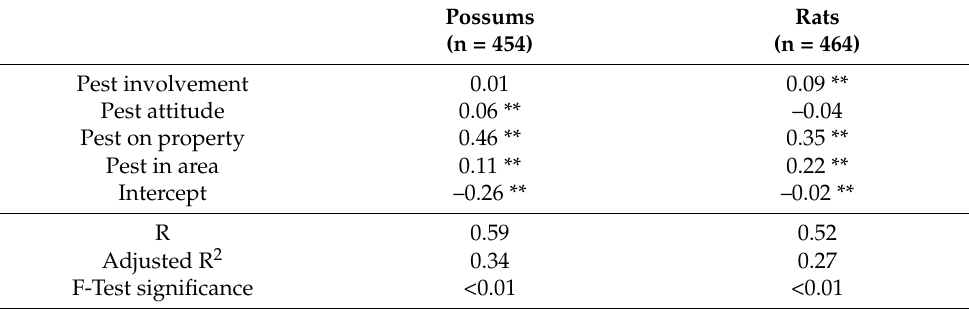
Table 11. Parameter estimates for trapping and